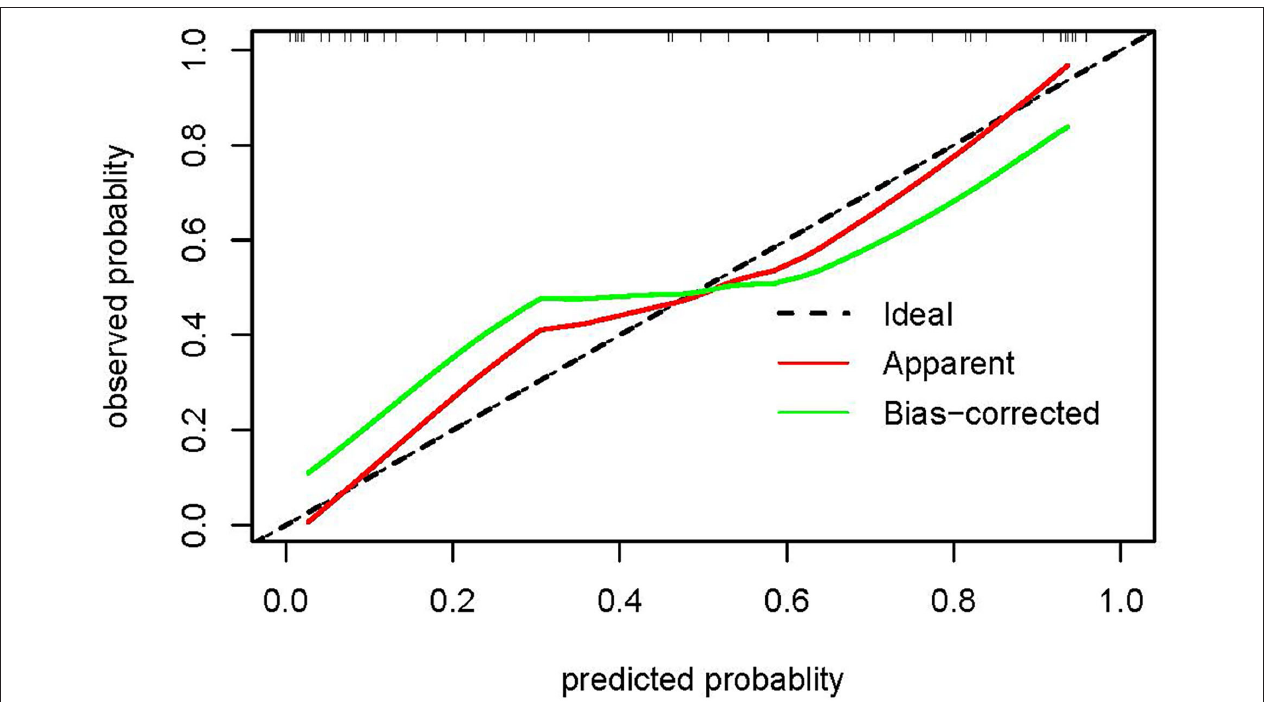
FIGURE 4 | The calibration plot of the nomogram in the validation dataset. The x-axis shows the nomogram-predicted probability of unresolved risk, and the y-axis shows the actual observed probability of unresolved risk. The ideal line (45 ◦ ) in the calibration plots represents perfect consistency between the nomogram-predicted probabilities and the observed probabilities. The apparent curve represents the model calibrated with the validation dataset, and the bias-corrected curve represents the model calibrated using the bootstrap